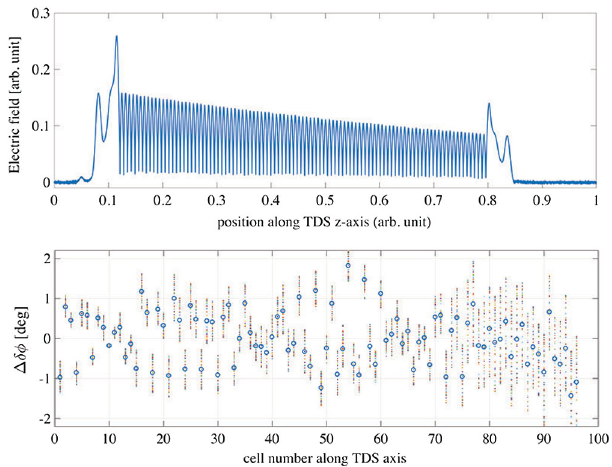
FIG. 27. Results of bead-pull measurements taken with 1 mm offset on the x -axis. First 3 plots on the top: electric field along the TDS for different polarizations. Oscillation peaks marked with red dots identify the iris position while the negative peaks marked with green dots identify the cell gap center. Bottom plot: ¼ mean value of the E-field measured at each cell middle point in between irises (green dots) vs input ports phase